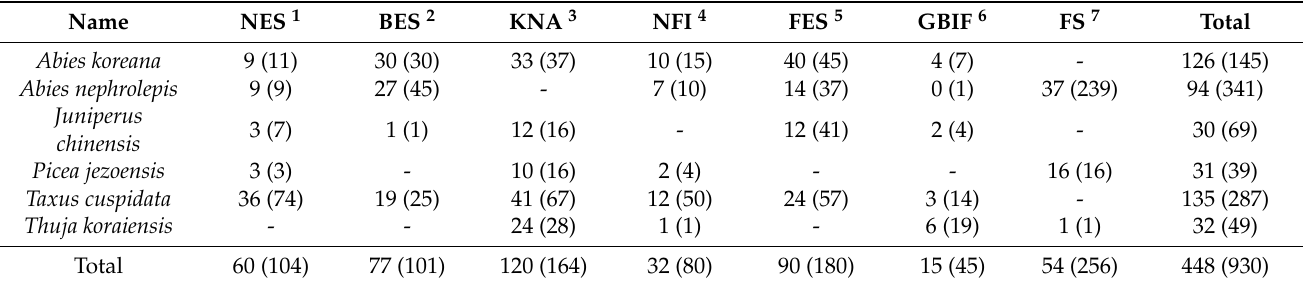
Table 1. Number of cleaned (collected) occurrence sites of six subalpine forest species for species distribution modeling.